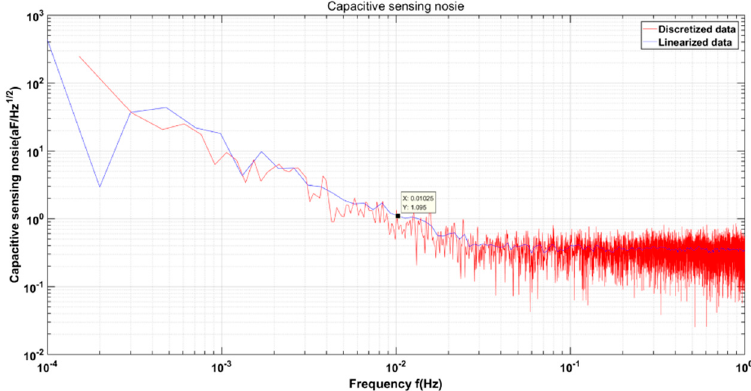
Figure 20. Capacitive sensing noise.